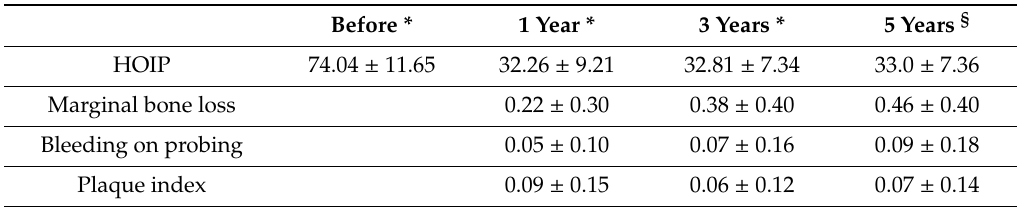
Table 2. Overall outcome measurements during